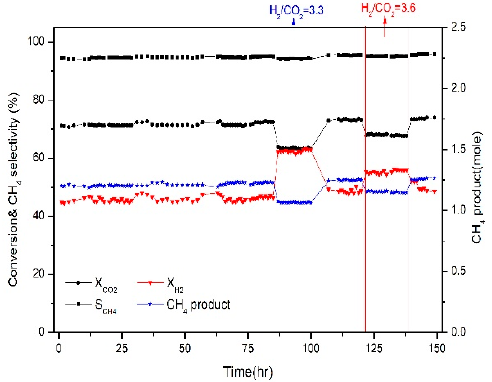
Figure 10. The durability and activity test of the catalyst for 130 h.